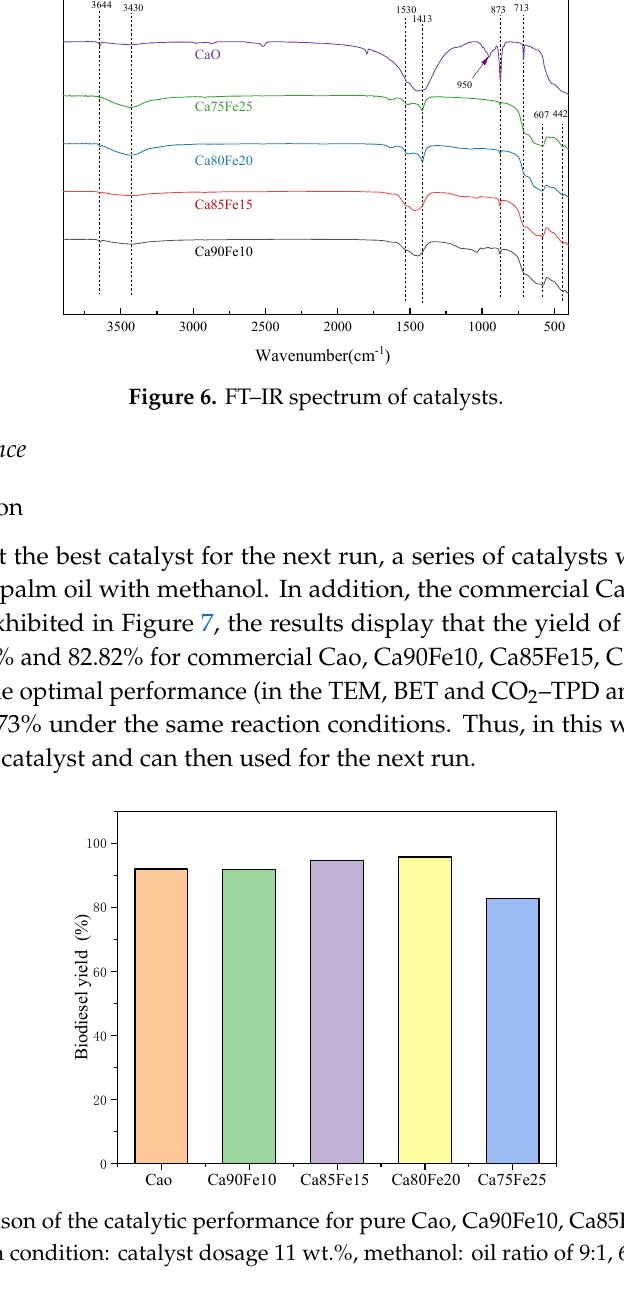
Figure 5. CO 2 –TPD curves of the catalysts.